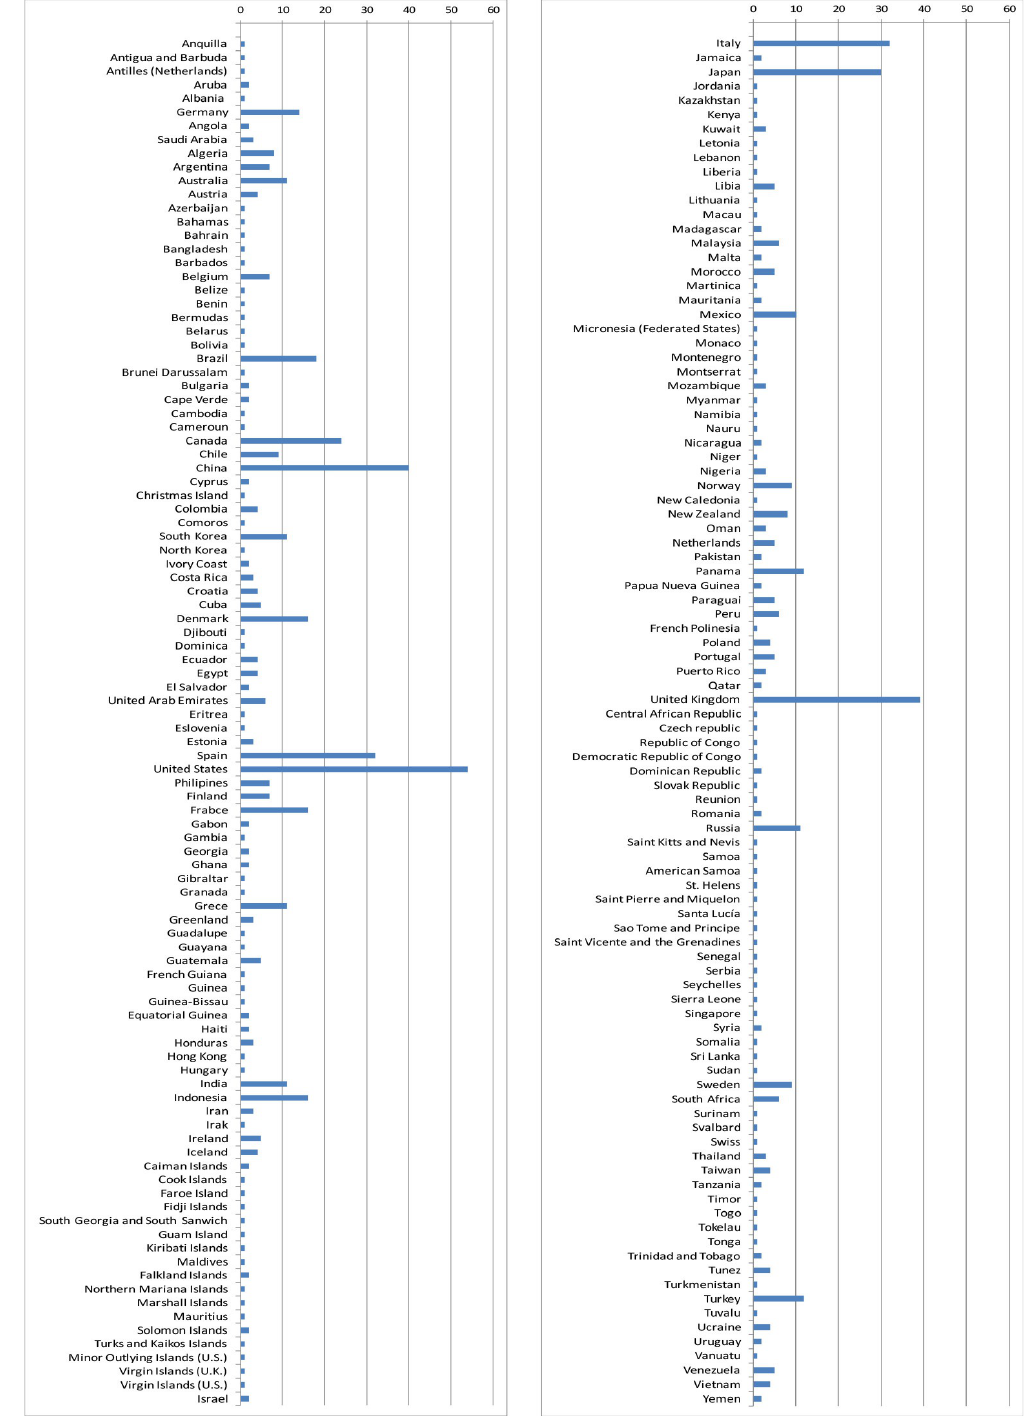
Figure 1. Ports studied in each